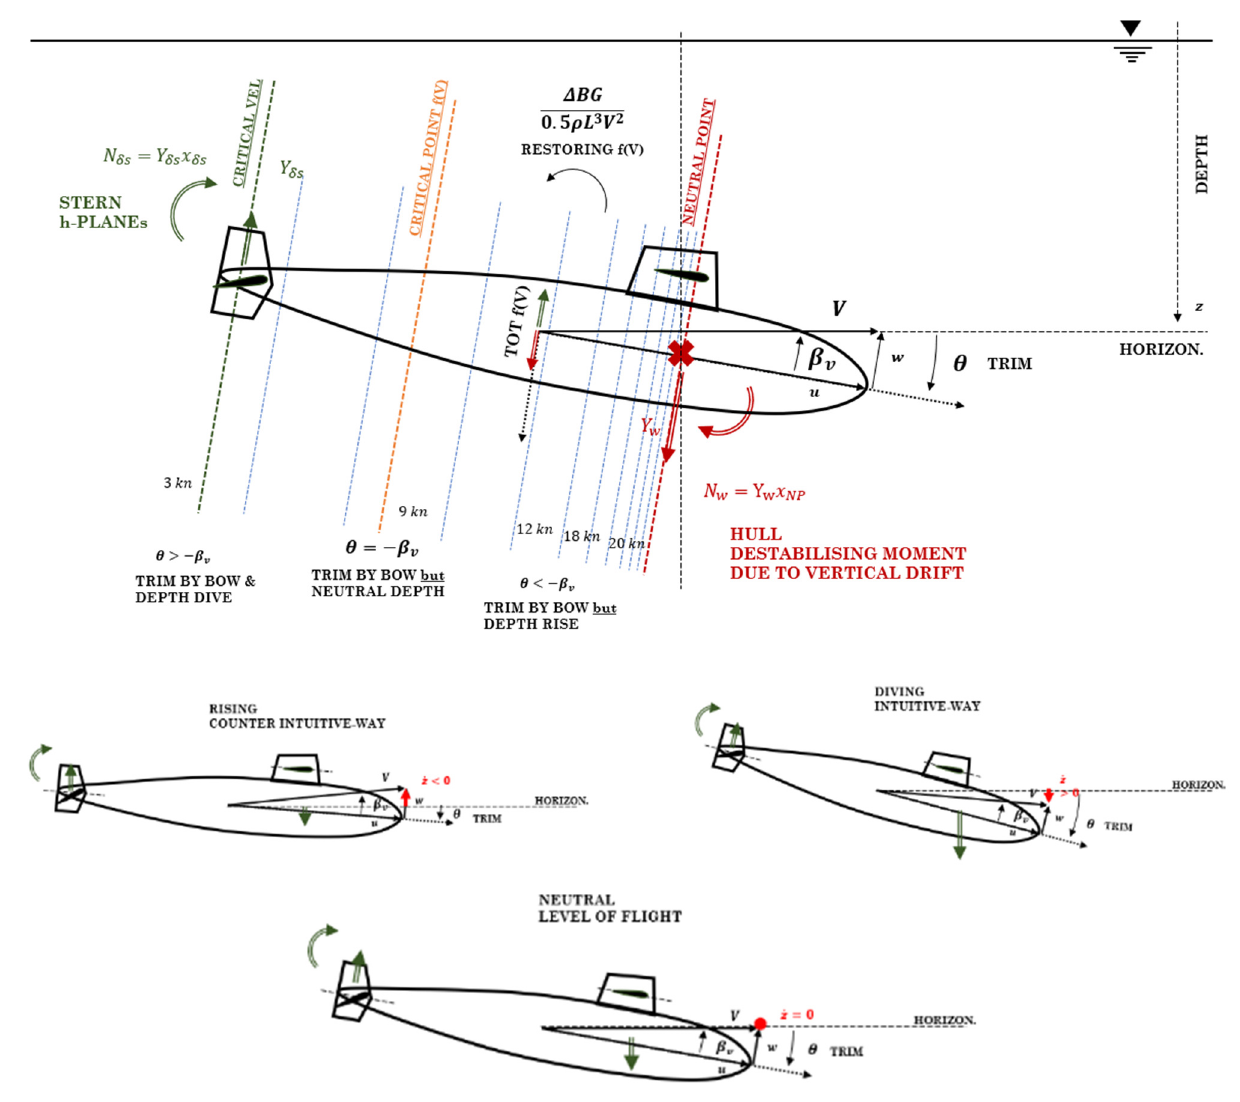
Figure A5. Depth change ability due to stern planes execution—critical point and velocity.